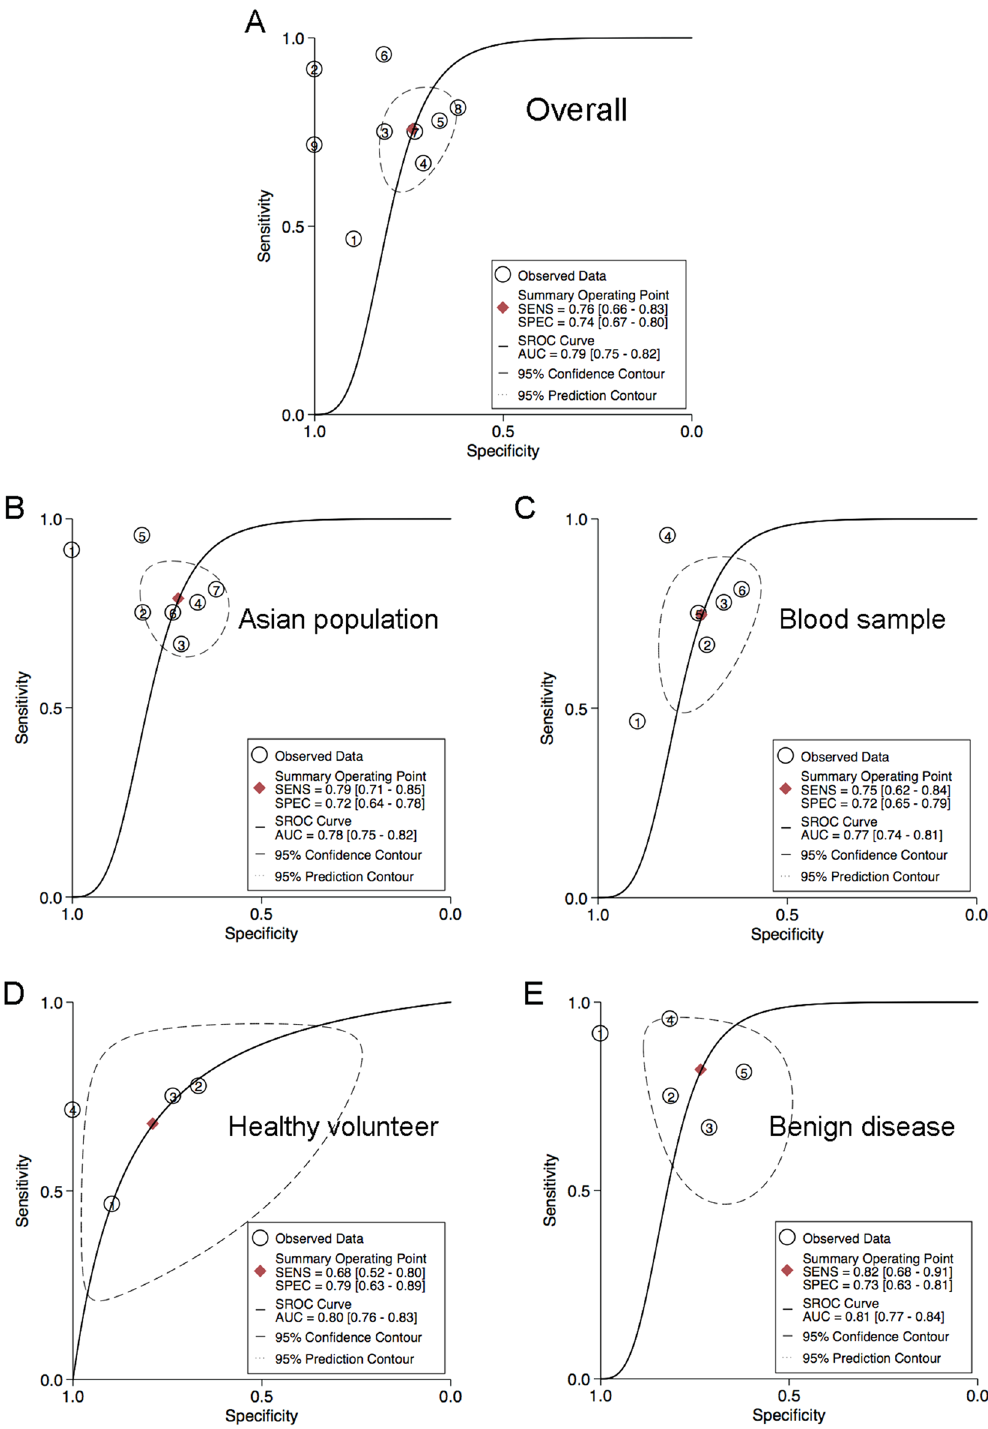
Figure 7. Summary receiver operating characteristic (SROC) curve of circulating hsa-miR-21-5p in PC diagnosis. ( A ) Summary receiver operating characteristic (SROC) curve of circulating hsa-miR-21-5p in the diagnosis of PC in overall patients. The summary receiver operating characteristic (SROC) curves of circulating hsa-miR-21-3p were conducted in subgroups, including Asian population ( B ), blood sample ( C ), healthy volunteer ( D ) or patients with benign disease ( E ) as controls. AUC: area under ROC curve; Sen: sensitivity; Spec: specificity; PC: pancreatic